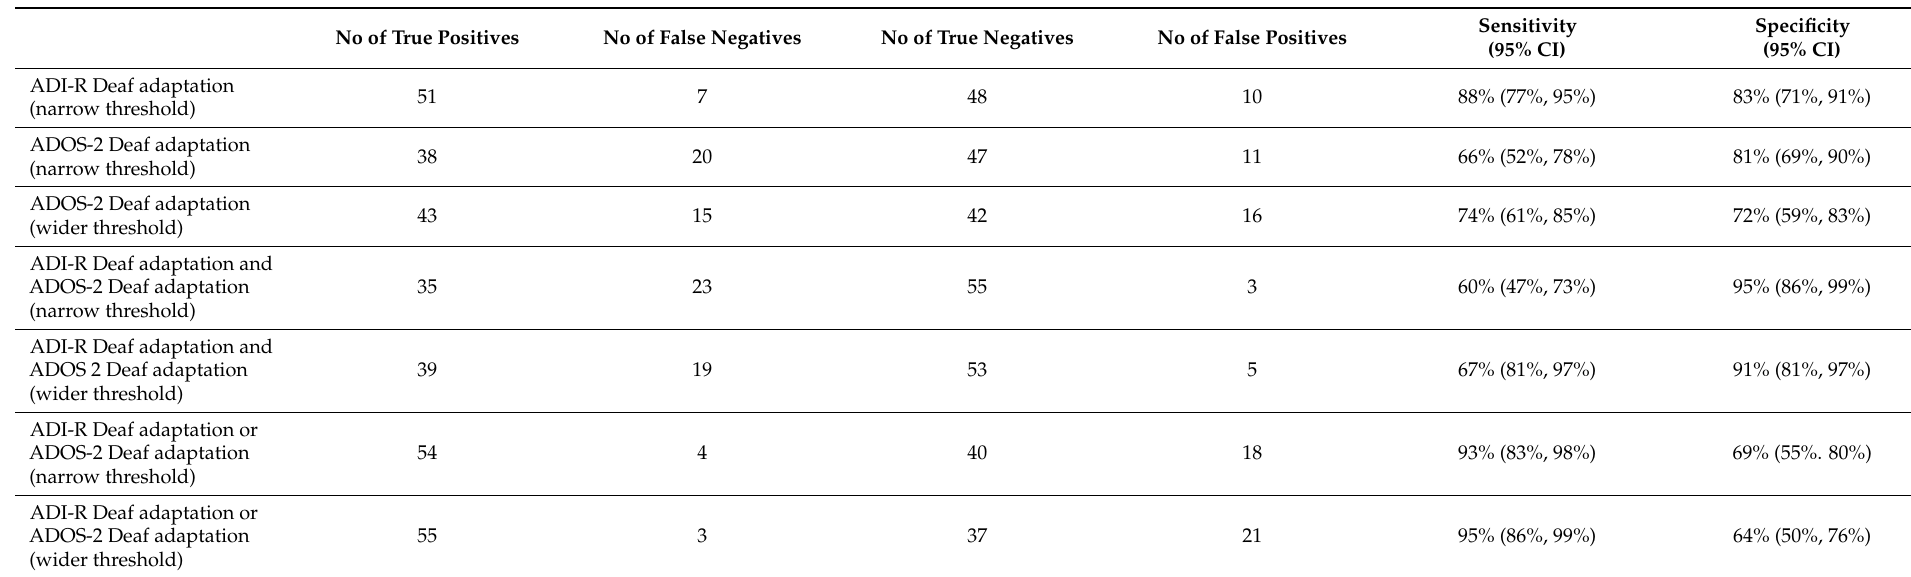
Sensitivity Specificity (95% CI) (95% CI)